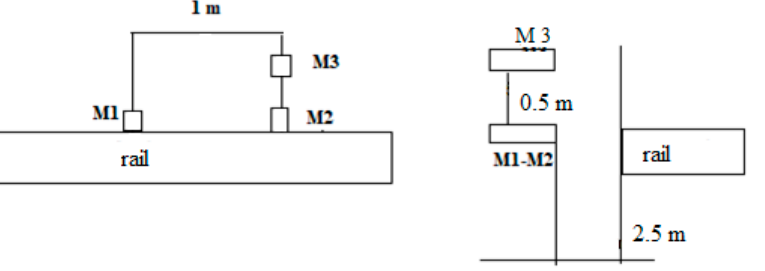
Figure 4. Microphone layout diagram. M1—microphone 270029; M2—microphone 190590; M3— microphone 186157